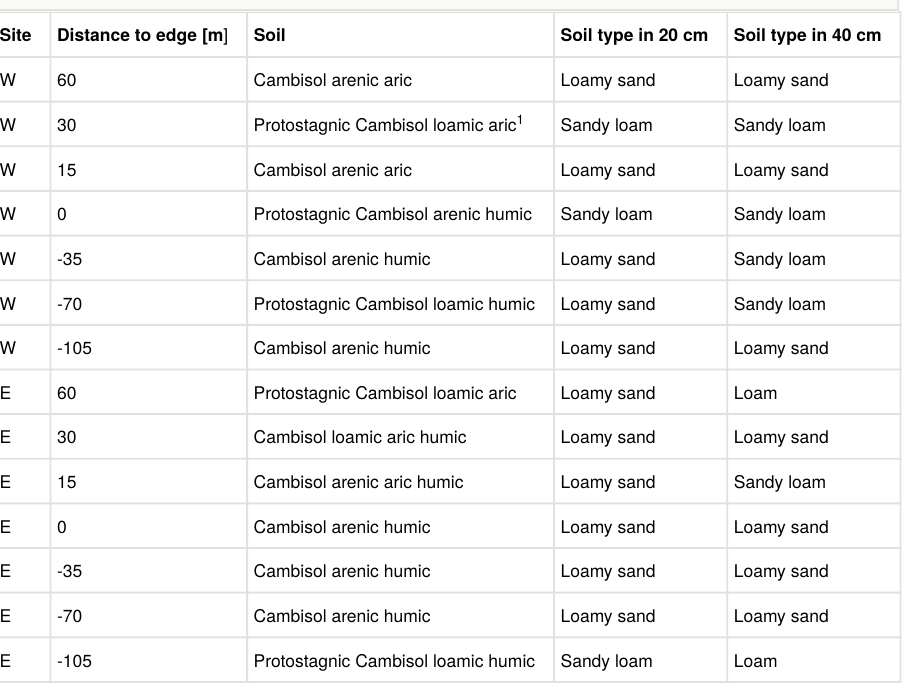
Soil classi fi cation according to WRB (FAO 2014) with soil textural classes for two di ff erent depth (20 ±3 cm and 40±3 cm) in a transect from forest (negative distances) to arable land (positive distances) and its zero line (edge; 0) at an east-facing site (E) and a west-facing site (W) in north- east Germany. This Cambisol was deeply eroded which cut o ff the cambic horizon and mixed it due to ploughing.